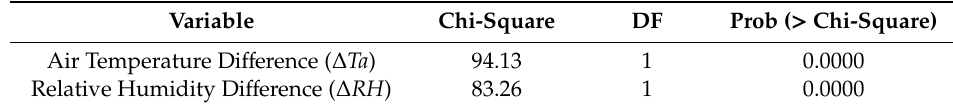
Table 1. Kruskal–Wallis one-way analysis of variance (ANOVA) of Air Temperature Di ff erence ( ∆ Ta ) and Relative Humidity Di ff erence ( ∆ RH ) between concrete land and bush Table 1. Kruskal – Wallis one-way analysis of variance (ANOVA) of Air Temperature Differenc e (∆ Ta ) and Relative Humidity Difference (∆ RH ) between concrete land and bush woodland.